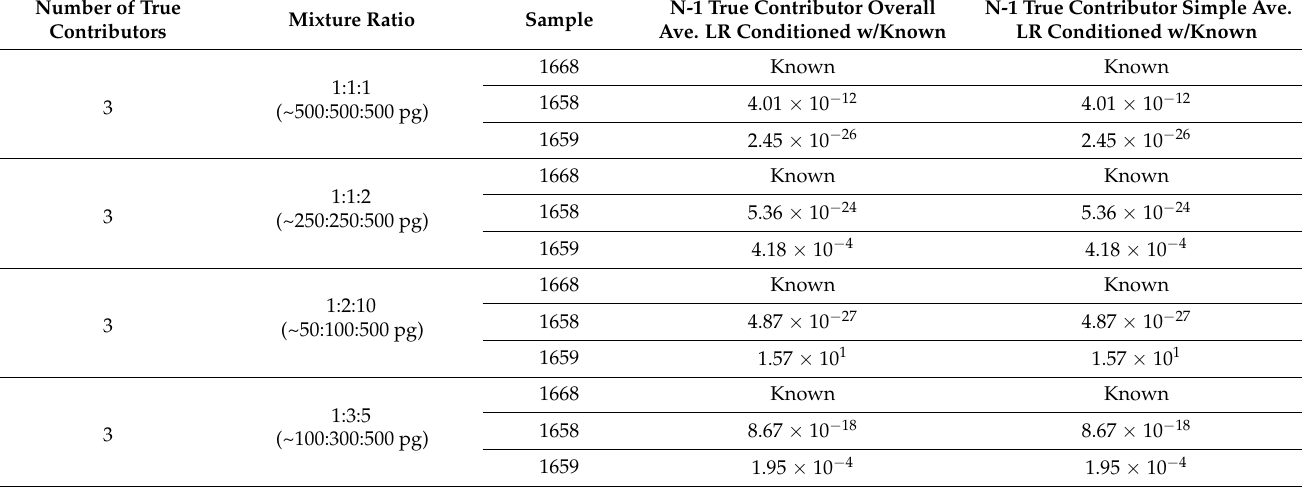
Table 7. Summary of the average (N = 5) calculated LR results conditioned with a known of the N-1 NOC tests for each of the component contributors in its respective mixture. The contributors in each mixture are listed in the order of the position and ratio that they occupied in the mixture. The four-person mixtures altered the sample order, depending on the ratio being tested, for additional variability. All data shown are from undiluted samples, with the approximate quantities of DNA template in each mixture indicated. Overall (sub-sub-source) LRs consider the position of the individual contributor in the mixture, while simple (sub-source) LRs do